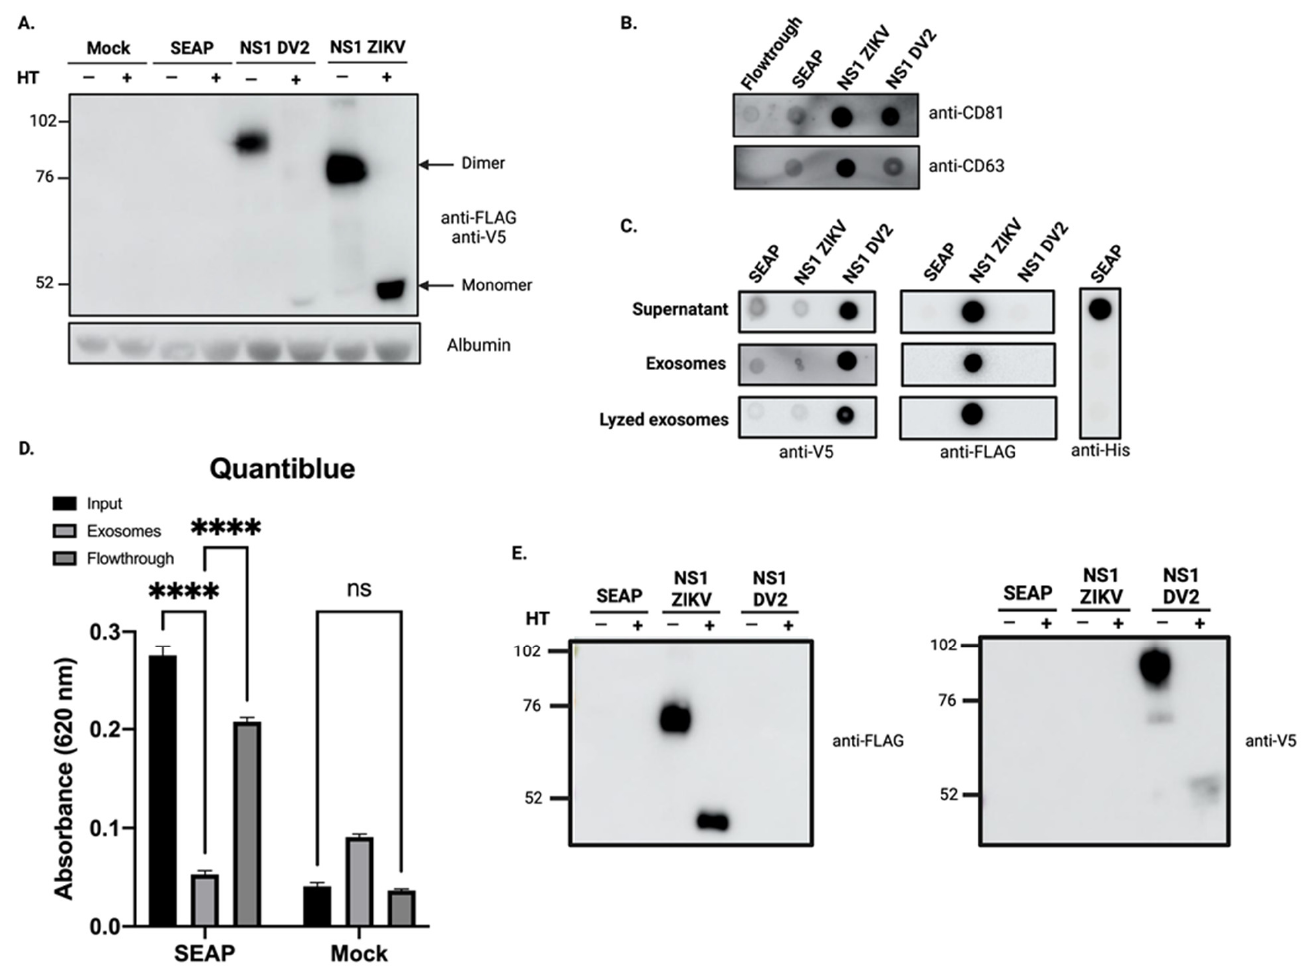
Figure 2. The overexpressed ZIKV-NS1 FLAG-tag and DENV2-NS1 V5-tag co-elute with exosome-like particles. ( A ) The recombinant ZIKV-NS1 FLAG-tag and DENV2-NS1 V5-tag , overexpressed in stable HEK cell lines, are present in the CCS, mainly as dimers. ( B ) The tetraspanins CD81 and CD63 are immunodetected in the exosome fractions of CCS from cells expressing the different secreted recombinant proteins. ( C ) When detecting the recombinant proteins in the CCS and exosomal fractions, only the NS1 proteins were detected in the exosomal fractions, and a similar signal was obtained whether or not the vesicles had been lysed. ( D ) SEAP activity was estimated by quantiblue assay. CCS and the flowthrough remaining from the exosome extraction, but not purified exosomes, exhibited SEAP activity. Ordinary one-way ANOVA test was performed using GraphPad Prism **** p < 0.0001, ns (not significant) ( E ) Western blot analysis of exosome protein extracts shows